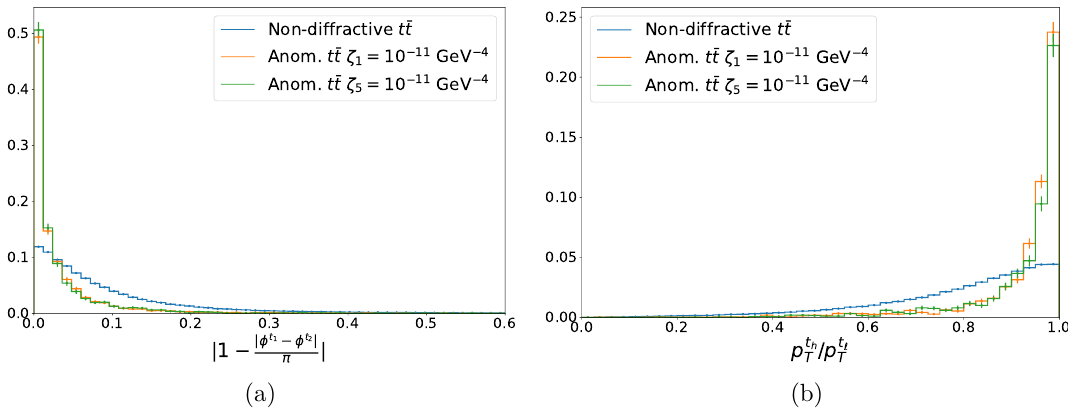
Figure 5. Acoplanarity (a) and transverse momentum balance (b), reconstructed from t ¯ t decay products. Only events passing the pre-selection are shown. Histograms are normalized to unity.